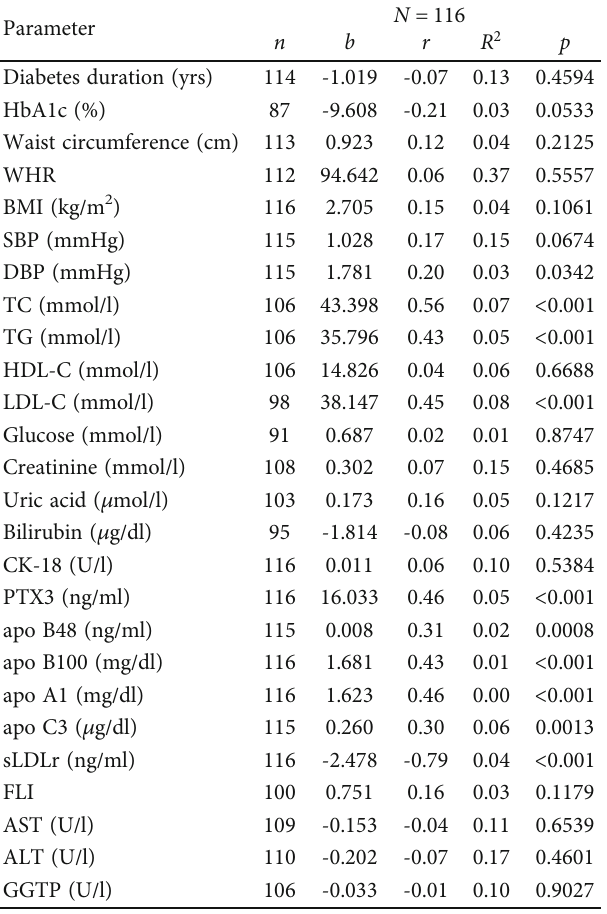
Table 4: Regression and partial correlation coe ffi cients between examined variables and PCSK9 in patients with type 2 diabetes mellitus, after adjustment for age and sex.